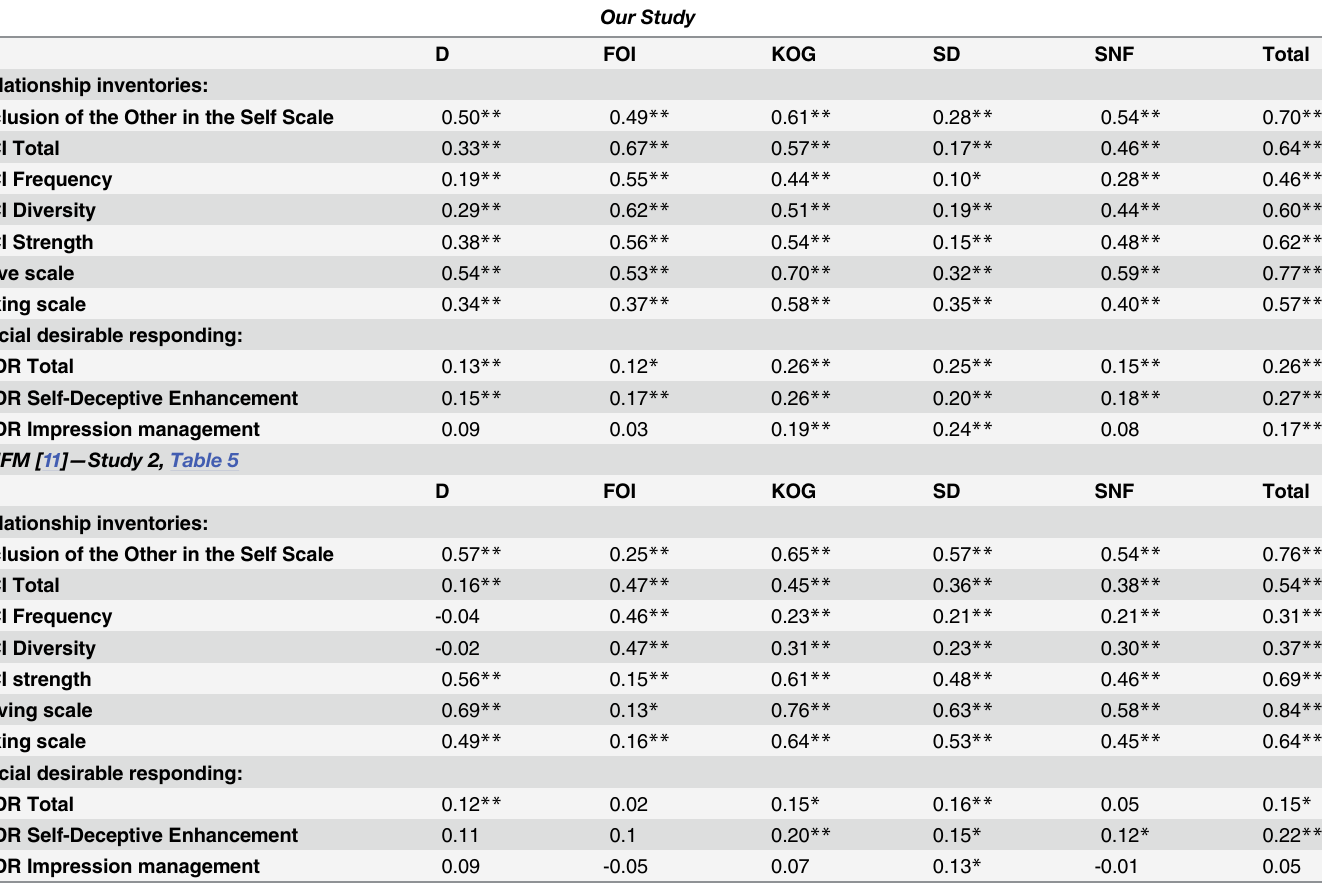
Table 4. Personal Acquaintance Measure (PAM)